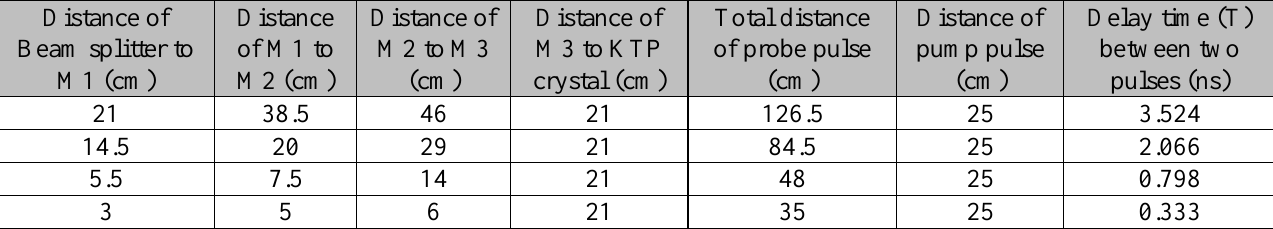
Fig.3: The pump–probe technique. Table 2: Represent the general dimension and parameter of pump-prop